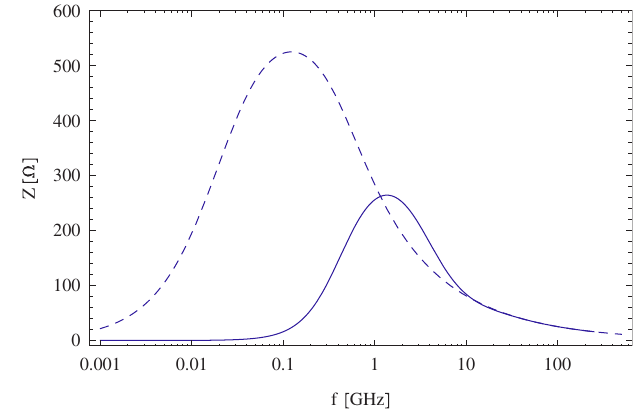
FIG. 27. Surface impedance of the ferrite damper, treated as a cylinder with 6 cm inner diameter radius and unbound outer diameter (dashed), or with 3 mm wall thickness (solid).